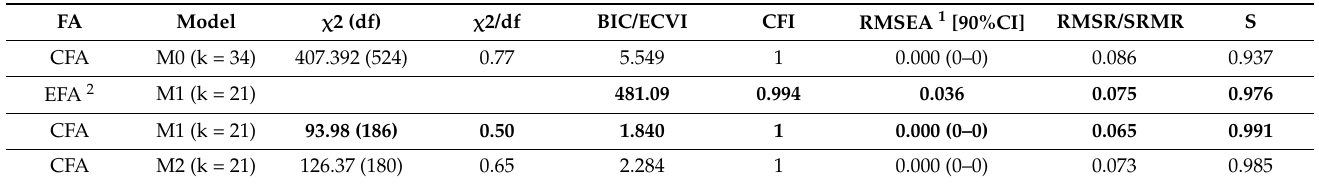
Table 4. Dimensionality models tested using EFA and CFA of the SECEL scale in the process of adaptation to the Spanish